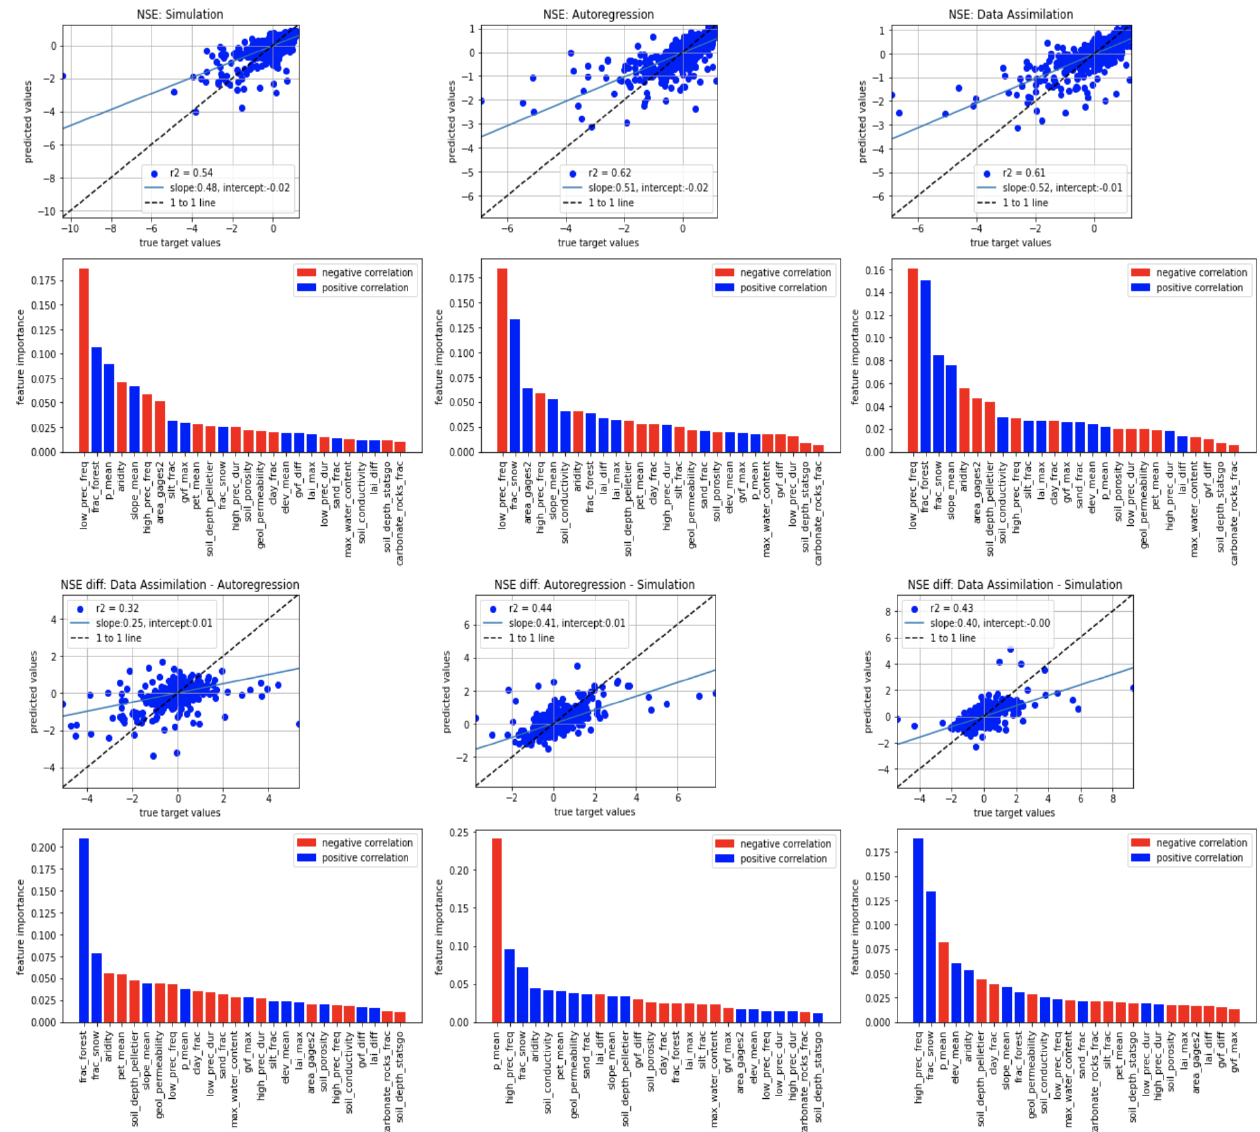
Figure G1. Scatterplots, r 2 metrics, and feature importances for predicting test-period NSE scores using different models (top subplots), and for predicting differences between models (bottom subplots). Bar charts show the feature importance for these predictions with blue indicating positive correlations between a given basin attribute and the NSE (or delta-NSE) and red indicating a negative correlation.